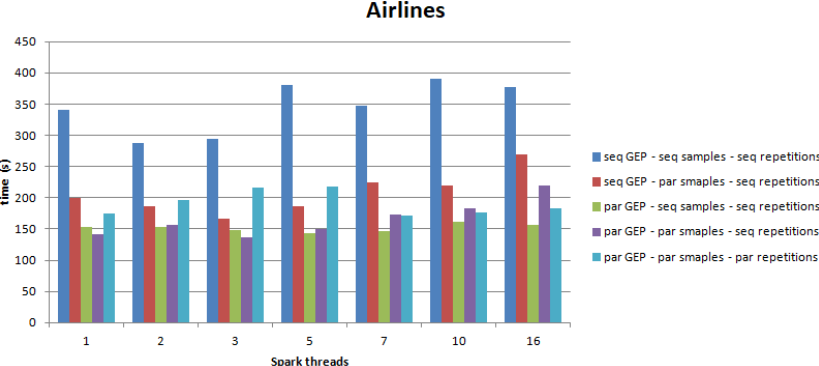
Fig. 4. Time (in s) of 10 repetitions of cross-validation classi¯cation for Airlines